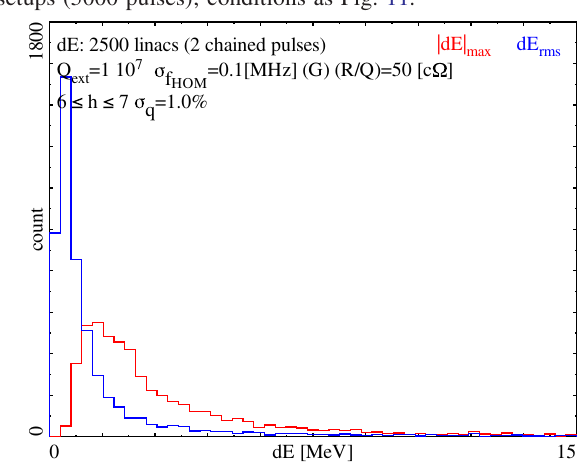
FIG. 22. (Color) Histogram of the last bunch before abort [0– 400 000, 50 bins] for Q ext ¼ 10 7 over 2500 different HOM setups (5000 pulses); conditions as Fig. 11.